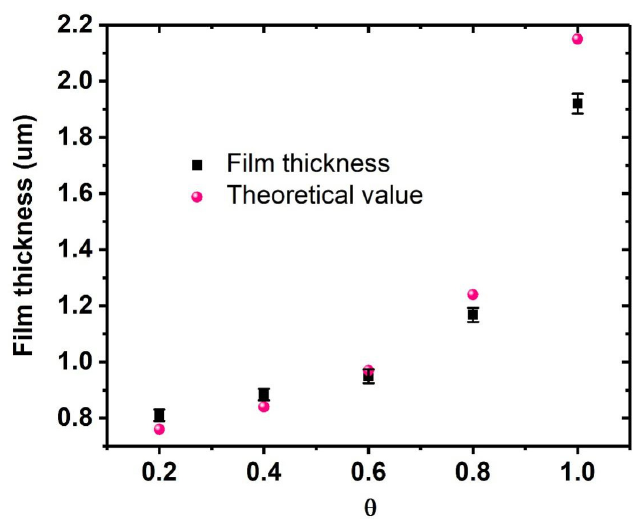
Figure 12. Experimental and theoretical value of film thickness on a spherical surface by spin coating.